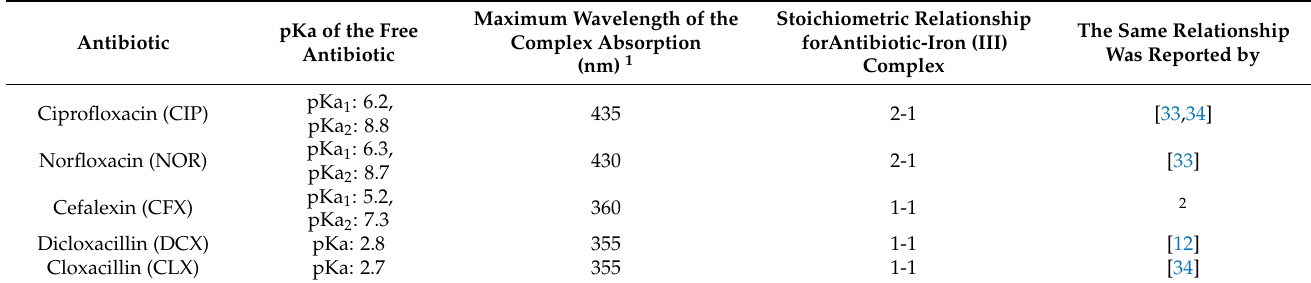
Table 2. Stoichiometric relationships for the complexes between the target antibiotics and the ferric ion. Maximum Wavelength of the Stoichiometric Relationship pKa of the Free The Same Relationship Antibiotic Complex Absorption forAntibiotic-Iron (III) Antibiotic Was Reported by (nm) 1 Complex Ciprofloxacin